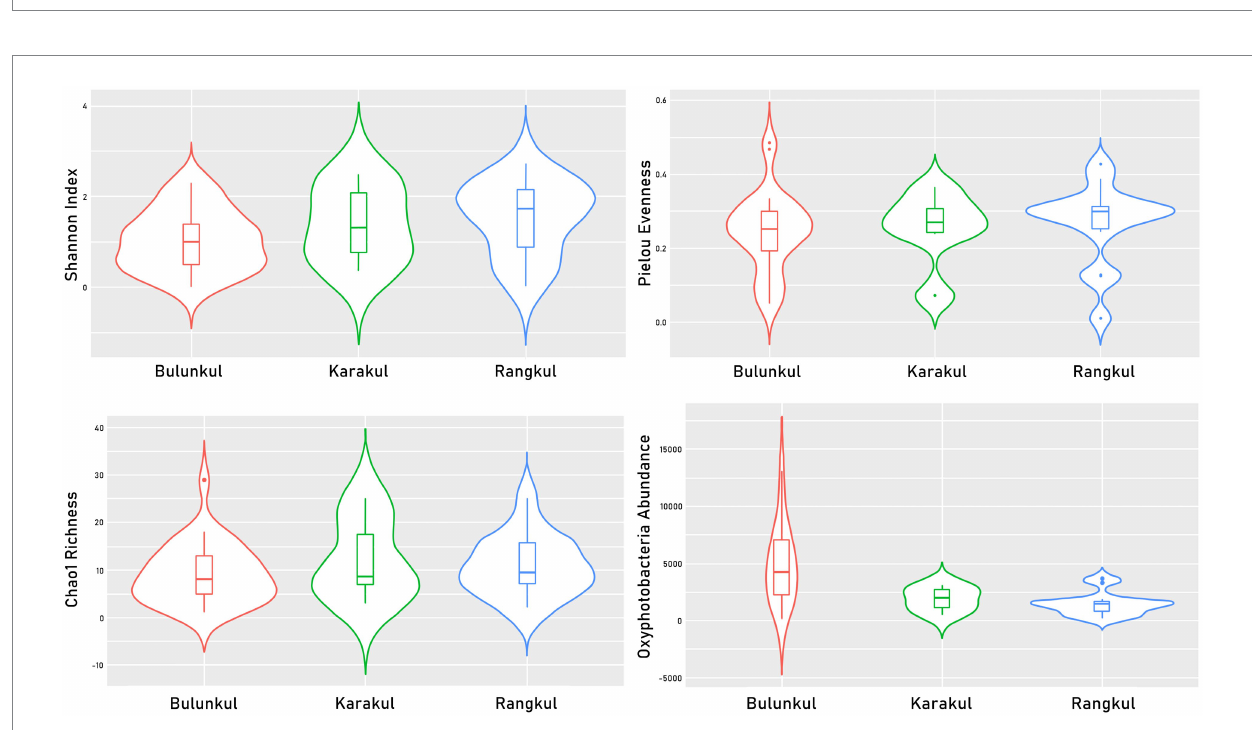
FIGURE 3 Violin plots presenting values of diversity indexes calculated for Oxyphotobacterial